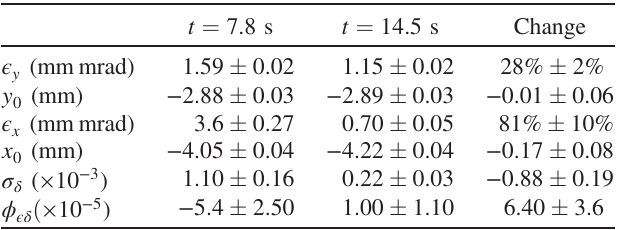
TABLE V. Intermediate plateau summary table. Note: Changes in emittance are expressed as percentages of initial emittance.